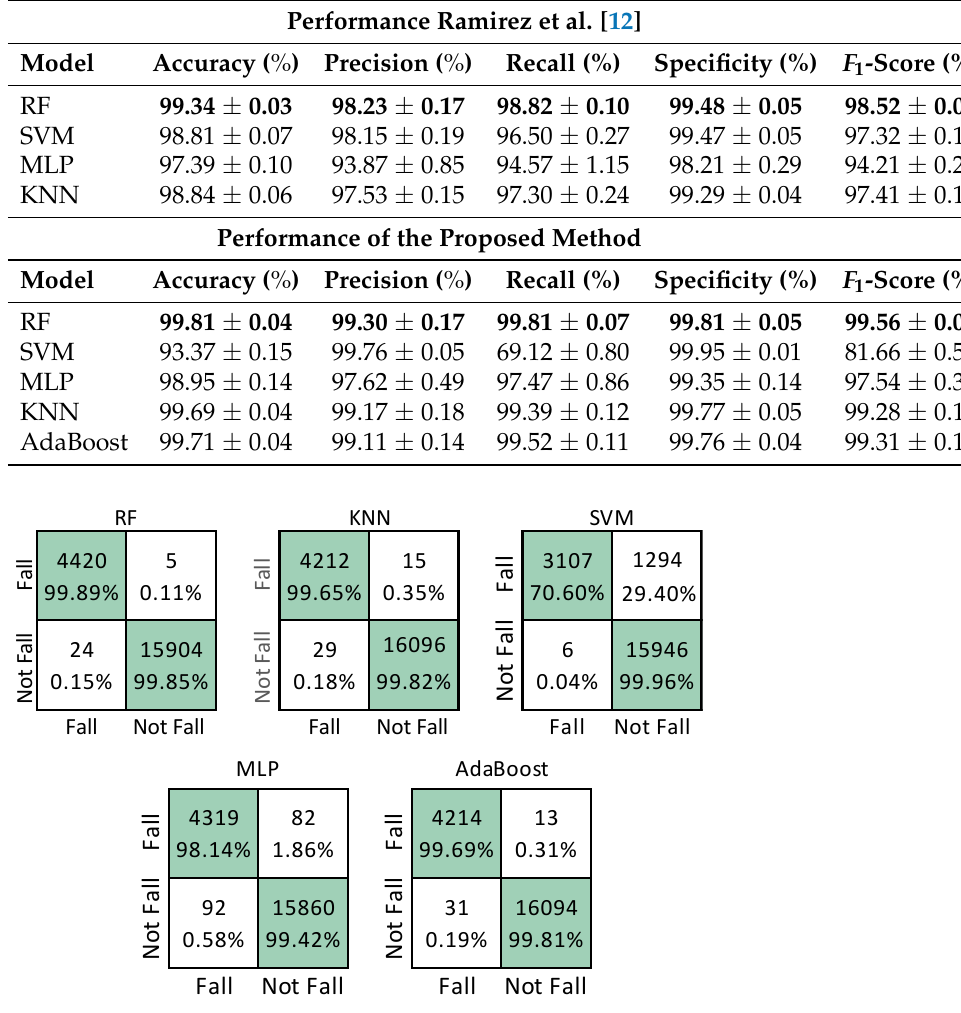
Figure 5. Confusion matrix for fall detection for RF, KNN, SVM, MLP, and AdaBoost, respectively. True positives (TP) are in the upper left corner; false positives (FP) are in the lower left corner; false negatives (FN) are in the upper right corner; true negatives (TN) are in the lower right